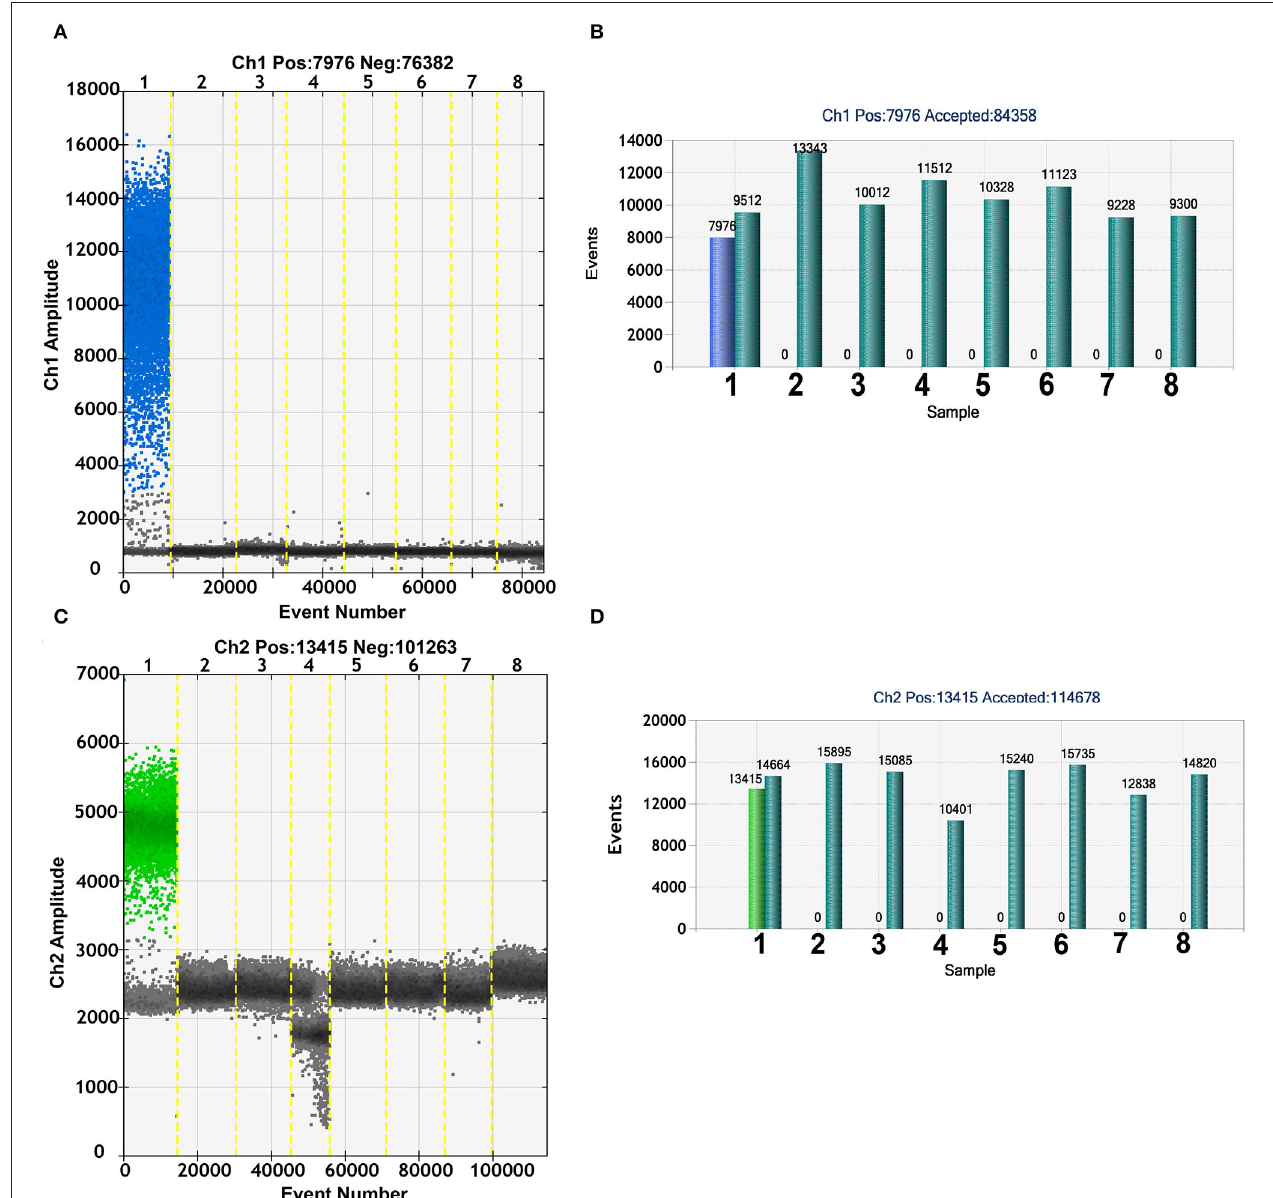
FIGURE 3 | Specificity of the duplex ddPCR assay. The fluorescence amplitude of African swine fever virus (ASFV) (lane1) B646L (A) and EP402R (C) amplification was observed without cross-reactivity with CSFV, PRRSV, PEDV, JEV, PPV, PCV2 (lanes 2–7), and NC (lane 8). The ratio of B646L (B) and EP402R (D) for classical swine fever virus (CSFV), porcine reproductive and respiratory syndrome virus (PRRSV), porcine epidemic diarrhea virus (PEDV), porcine parvovirus (PPV), Japanese encephalitis virus (JEV), porcine circovirus type 2 (PCV2) (lanes 2–7), and NC (lane 8) positive events to total partitions was